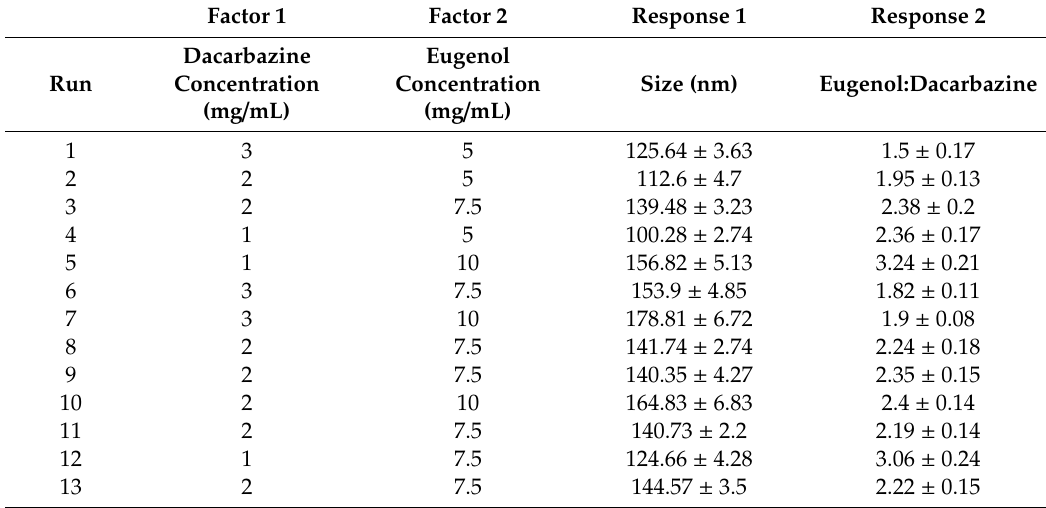
Table 6. Response data analysis (Second level). Values of Response 1 and Response 2 for 13 different combinations of Factor 1 and Factor 2.